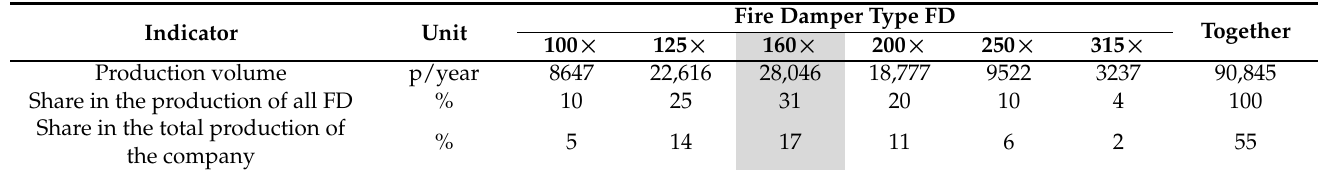
Table 1. Selection of the main representative of the production of fire damper.